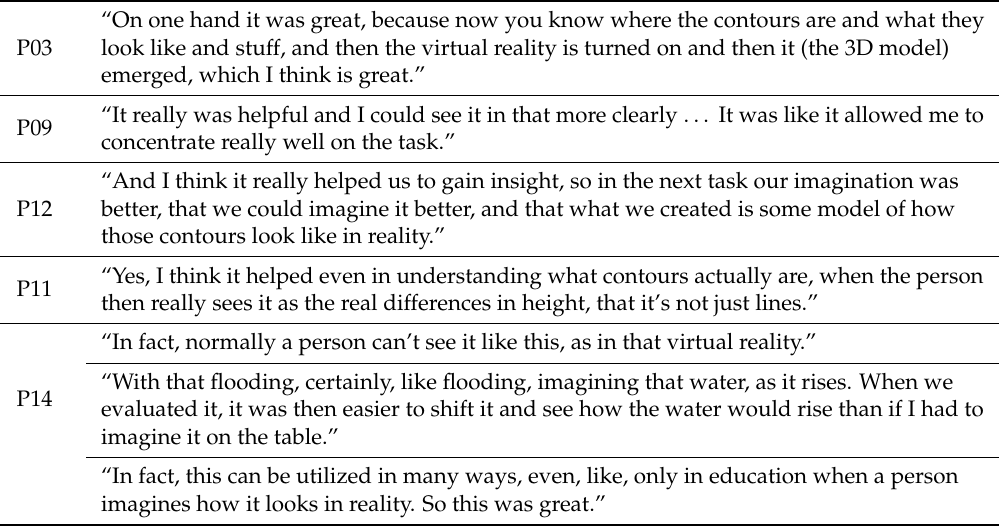
Table 3. Verbatim excerpts of statements by participants: Finally seeing what contour lines represent in